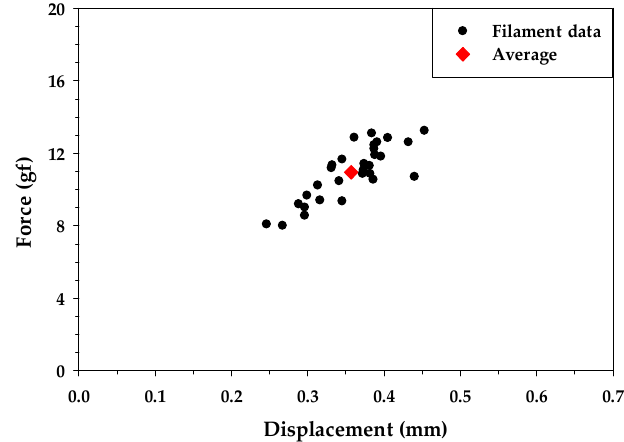
Figure 4. The procedure of carbon fiber recycling. ( a ) CFRP bicycle frame scrap before microwave ‐ assisted pyrolysis; ( b ) microwave ‐ assisted pyrolysis applied specimen; ( c ) recycled carbon fiber by cutting; ( d ) recycled carbon fiber dispersed by pneumatic dispersion.